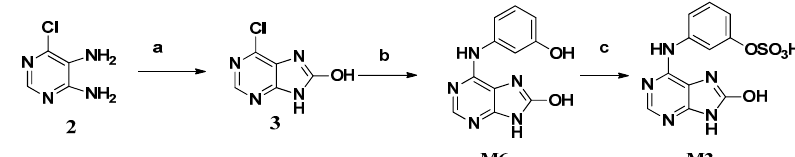
Scheme 2. The synthesis of M3 and M6 .